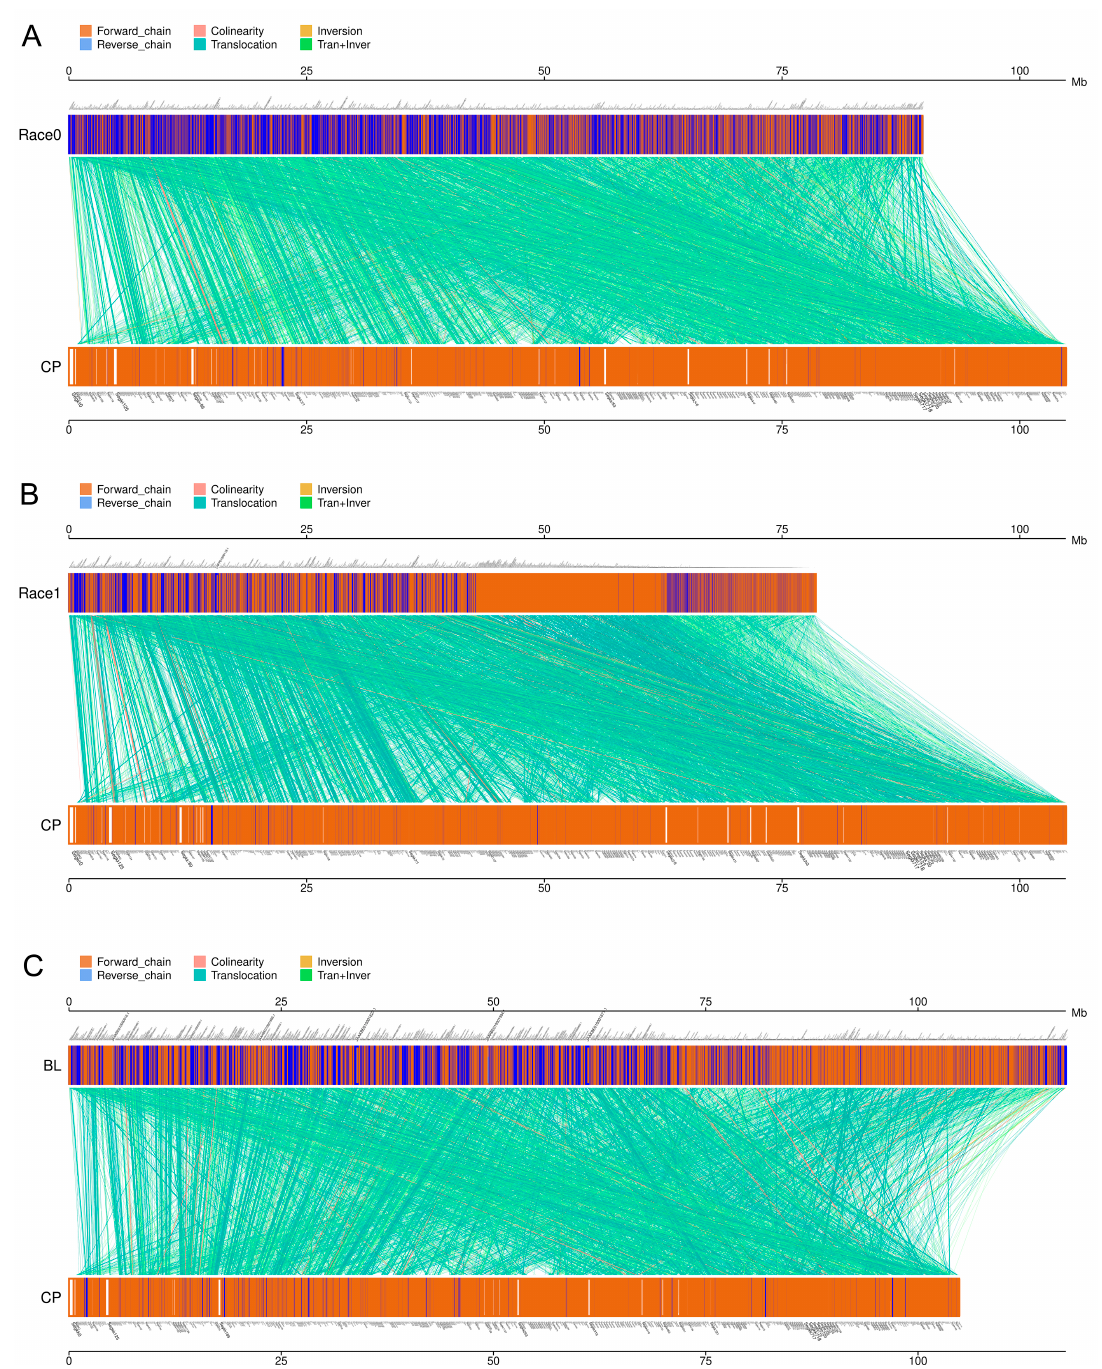
Figure 6. Syntenic regions comparison of four Ph. nicotianae genomes. The wide horizontal lines in red, blue, and green represent the assembled scaffolds in Ph. nicotianae JM01, Ph. nicotianae race 0, Ph. nicotianae race 1 and Ph. nicotianae BL. MUMmer software (Version 3.23) was used to analyze the genome synteny between any two genomes. ( A ) Collinear blocks between Ph. nicotianae JM01 and Ph. nicotianae race 0. ( B ) Collinear blocks between Ph. nicotianae JM01 and Ph. nicotianae race 1. ( C ) Collinear blocks between Ph. nicotianae JM01 and Ph. nicotianae